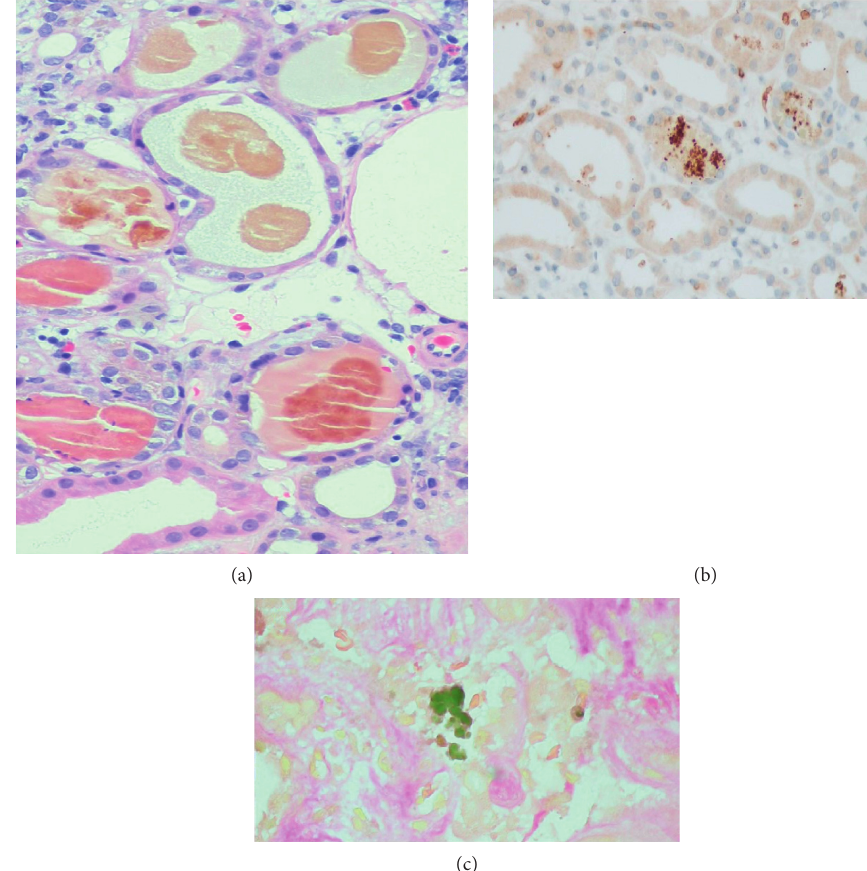
Figure 2: (a) Renal biopsy showing tubular casts comprising of hemoglobin (hemoglobin immunostained (b)) and bile pigment (Fouchet stained (c)). Glomeruli and vasculature were within normal